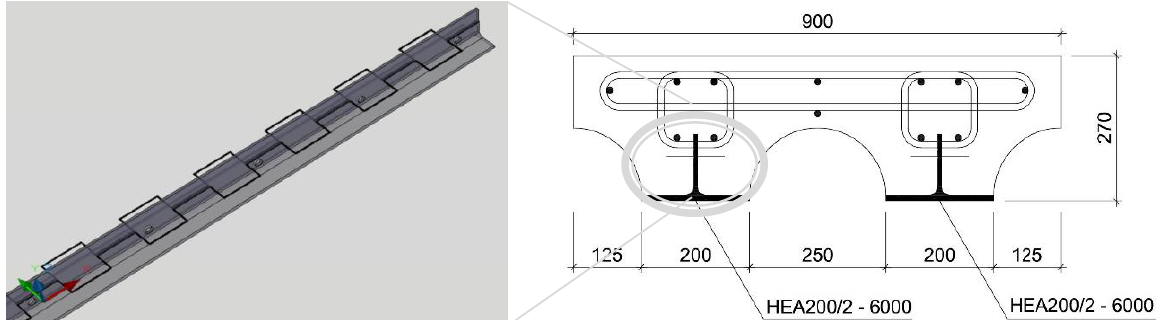
Fig. 3. Cross-section of beam NV2 with composite action using reinforcement